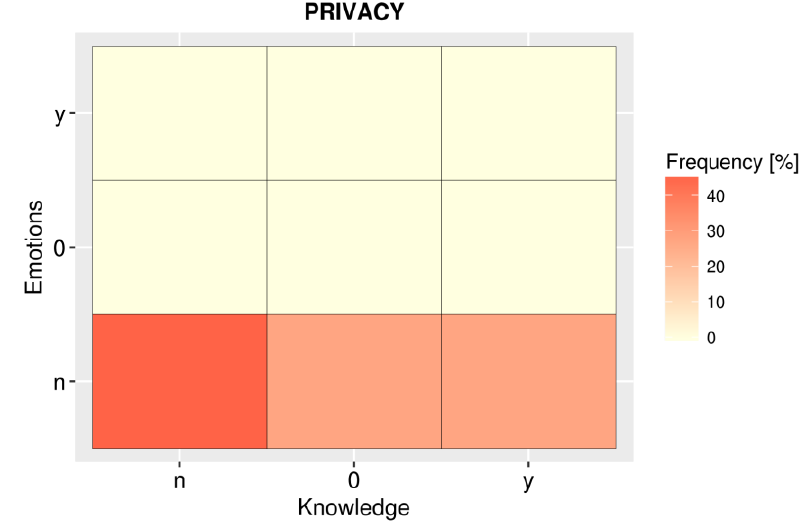
Figure 10. Frequency of responses compared between the knowledge and emotions dimensions—privacy theme.